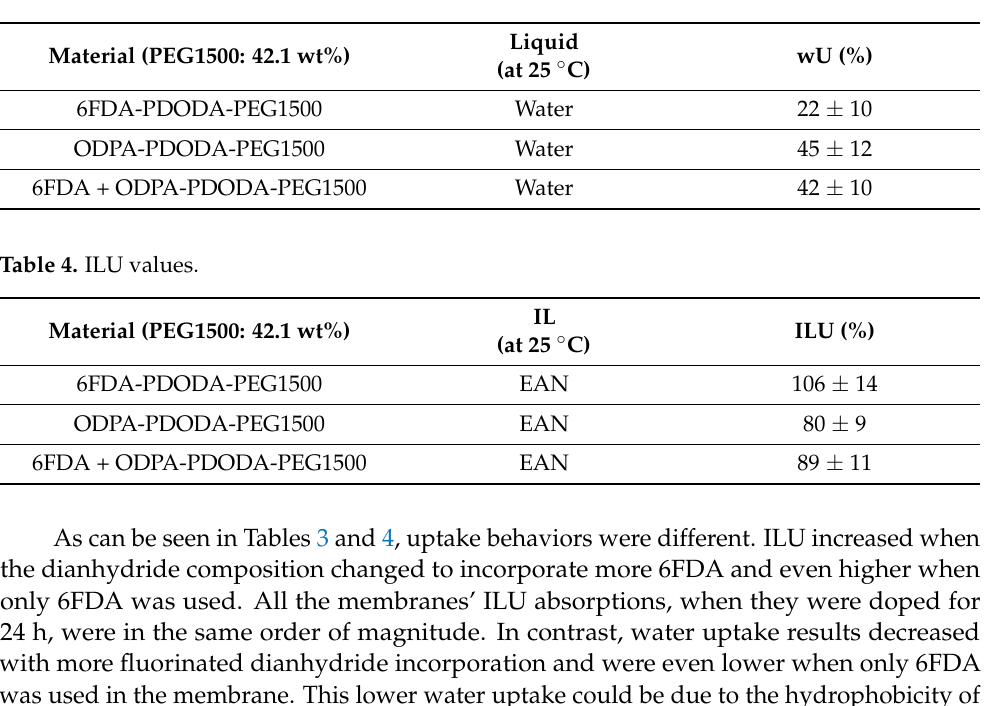
Table 3. WU values.